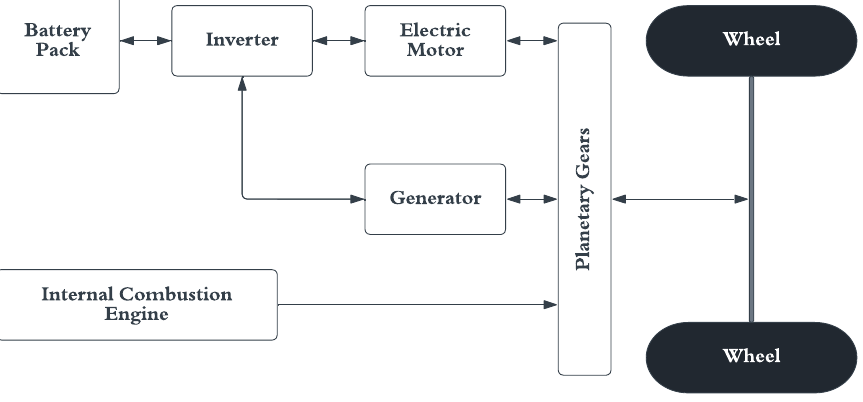
Figure 3. Drive system of a hybrid electric vehicle.